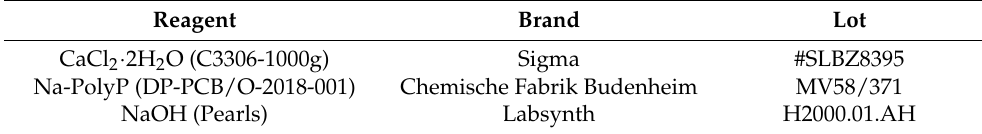
Table 2. Main reagents used for the synthesis of calcium-polyphosphate (CaPP).